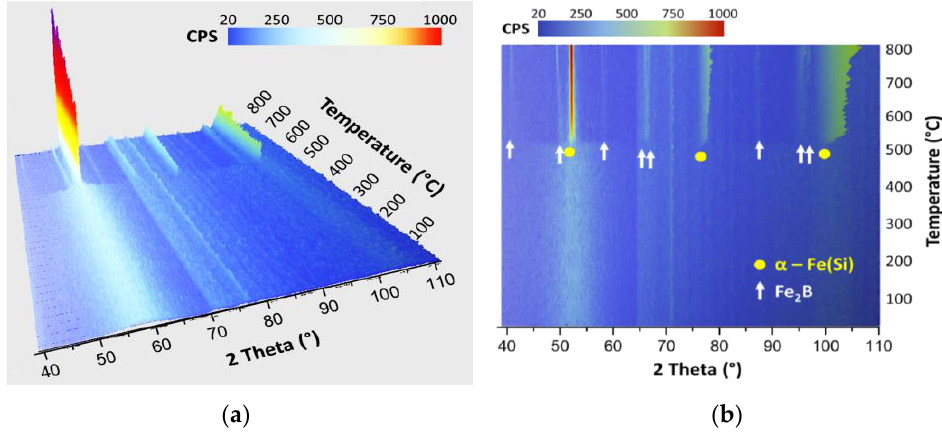
Figure 3 . In-situ HT-XRD analysis of the fibres. ( a ) the isometric view of the in-situ HT-XRD plot; ( b ) the top-down view of the in-situ HT-XRD plot.